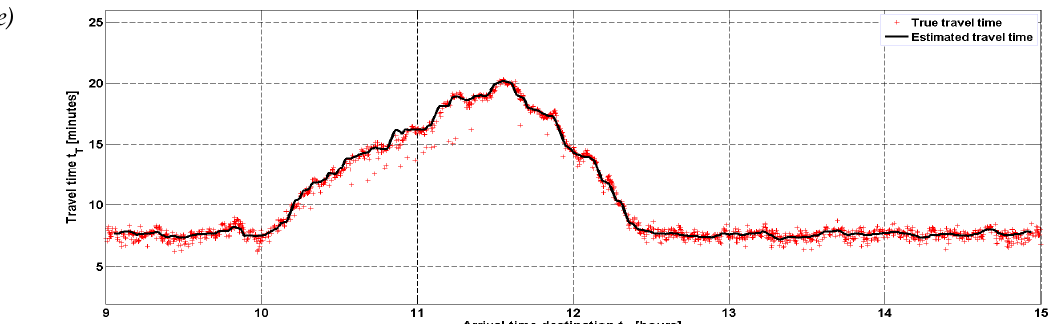
Figure 2. A graphical representation of the score matrix at some important steps within the travel time estimation procedure: (a) Raw score matrix (b) Score matrix after convolution, (c) Score matrix after weighting of the diagonals, (d) Score matrix after resizing and filtering, (e) Estimated travel time after finding the path with maximum costs from (2d), and comparison of estimated travel times (black line) with true travel times (red